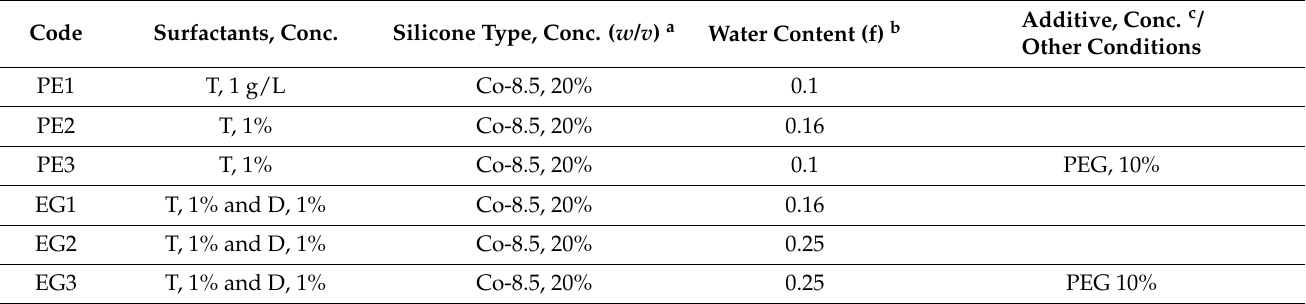
Table 1. Components of the emulsion